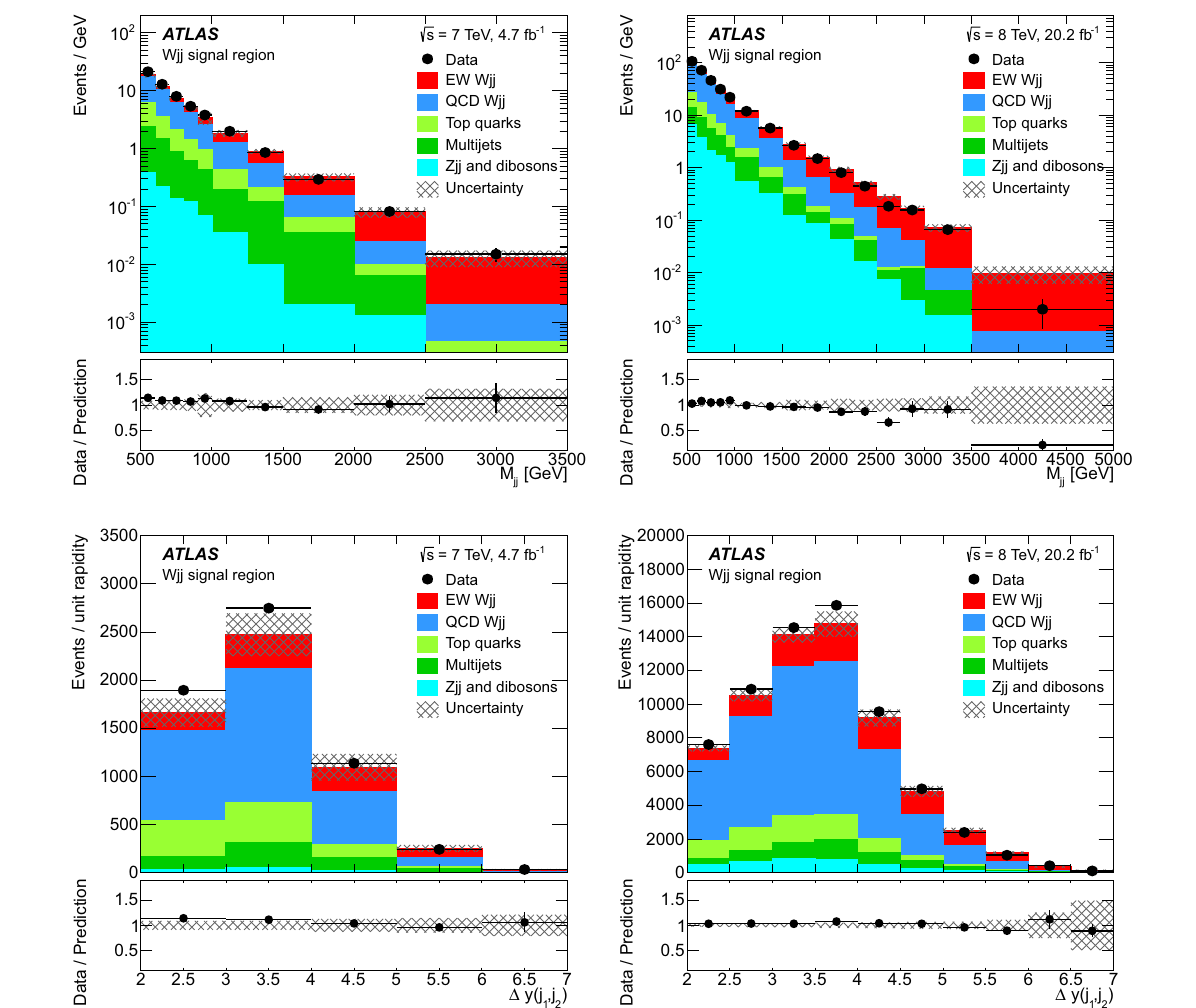
Fig. 6 Predicted and observed distributions of the dijet invariant mass ( top ) and (cid:6) y ( j 1 , j 2 ) ( bottom ) for events in the signal region in 7TeV( left )and8TeV( right )data.The bottompanel ineachdistribution